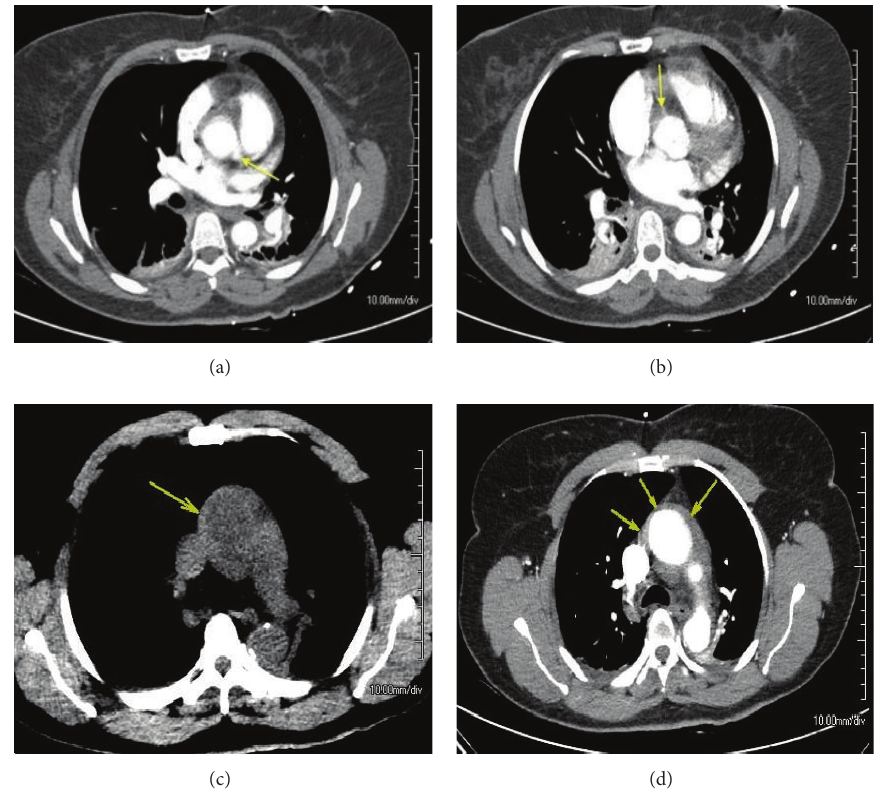
Figure 7: (a)-(b) CT angiogram at the level of the LCA and RCA, respectively (yellow arrows). (c)-(d) Arrows indicate the area of increased intensity suspicious for hemorrhage before (c) and after (d) contrast